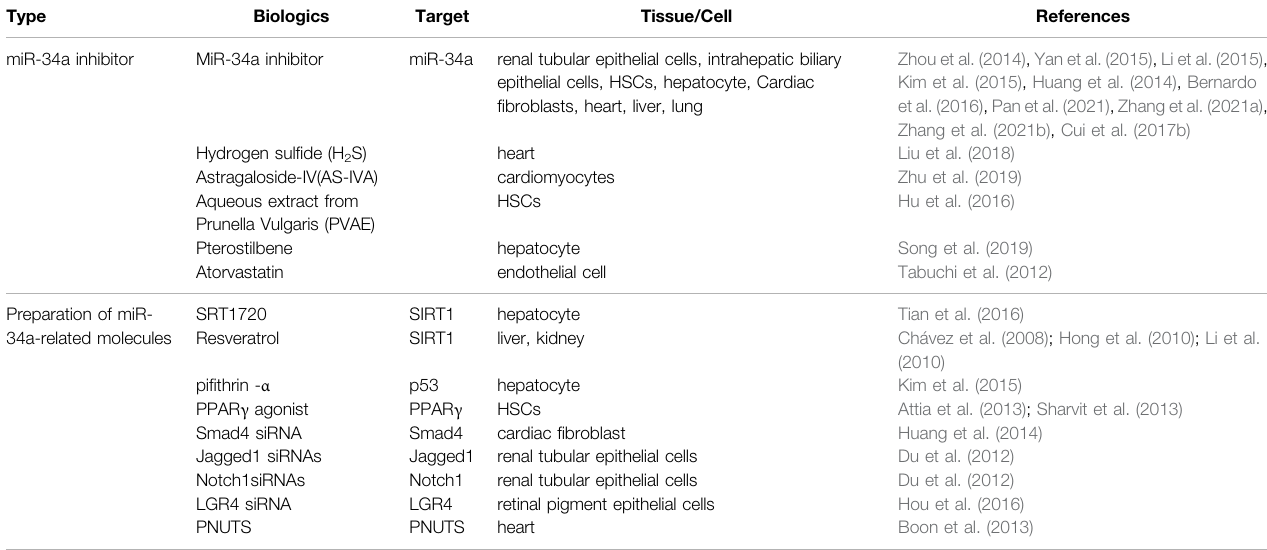
TABLE 2 | the biological agents of miR-34a and related molecules for fi